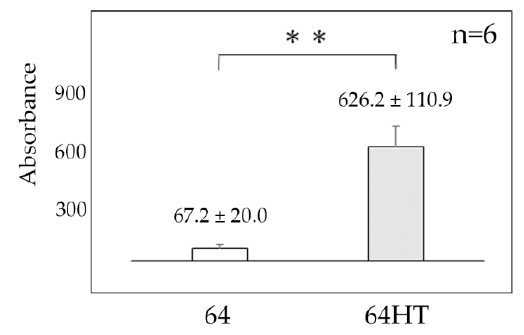
Figure 3. The adsorbed amount of laminin-332 on the surface of 64 and 64HT plates. Data are shown as the mean ± SD. Statistical analysis was by t -test (** p < 0.01).